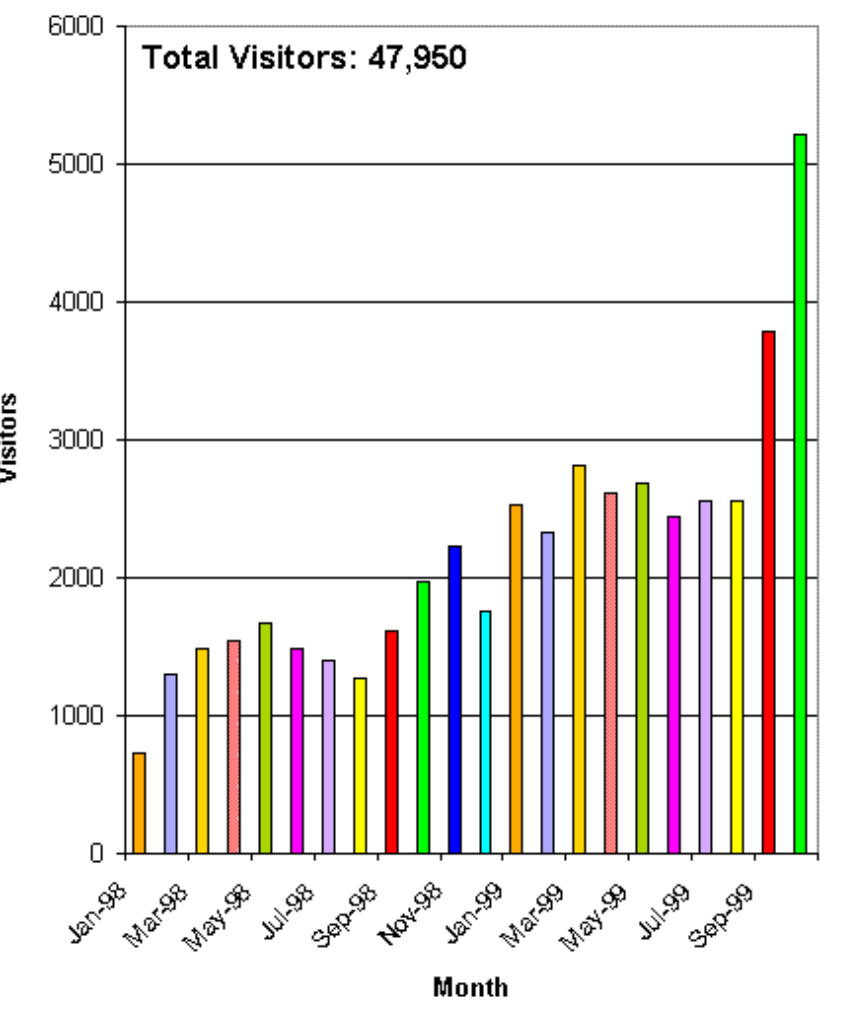
Figure 3. Number of times The Basics of NMR was accessed per month since January